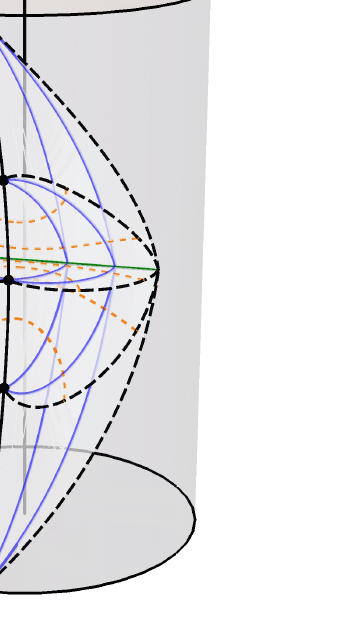
Figure 8 . The Class I rapid,B solution embedded within global AdS 3 . The particle worldline is shown in solid black. Several surfaces of constant t are plotted. The event horizons are demonstrated by the surfaces at early and late t . The bifurcation surface is shown as a green line. The surfaces x = x + and x 0 = x + identified. Lines of constant t within these surfaces are shown in long-dashed black. None of the conformal boundary is included in the solution. Lines of constant x are shown in blue, with lines of constant y in dashed orange. To guide the eye, the axis of the cylinder is also shown in